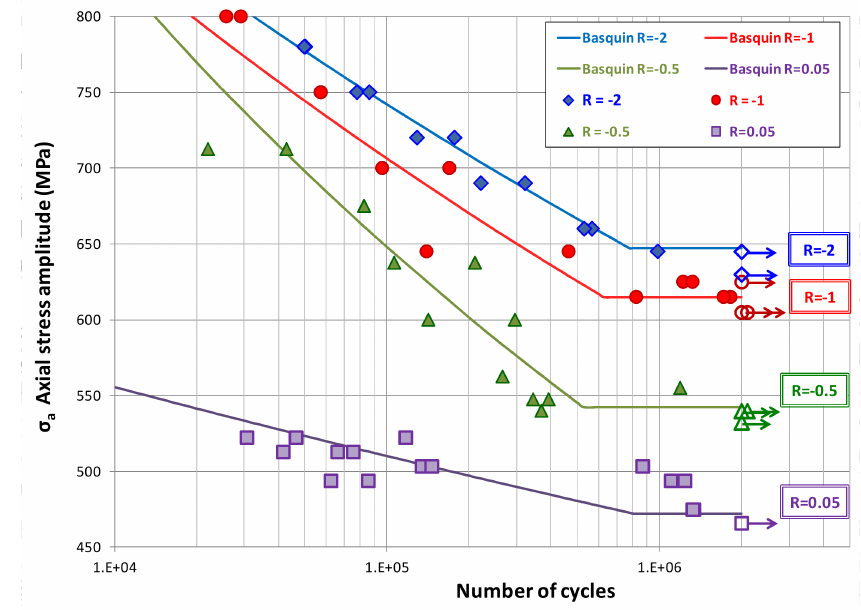
Figure 5. Experimental S - N fatigue curves of DIN 34CrNiMo6 steel for different stress ratios ( R